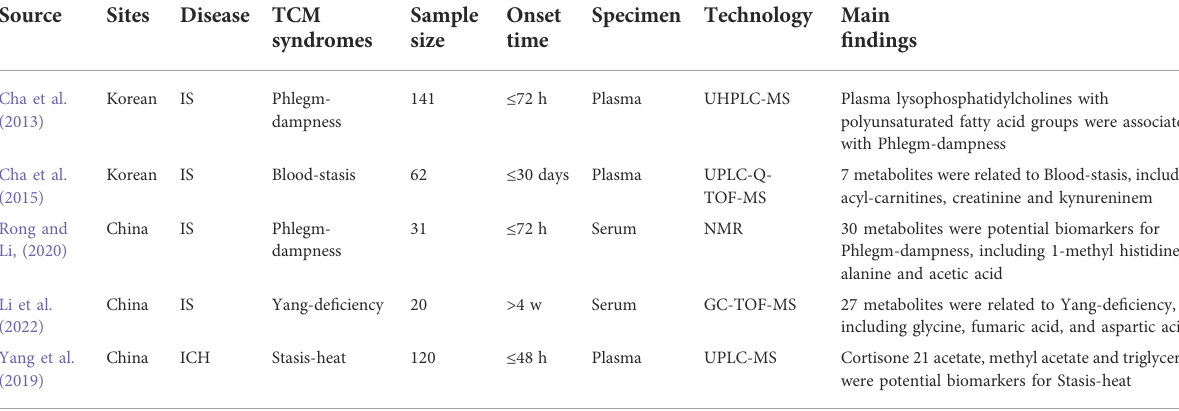
TABLE 4 Summary of the main fi ndings of the included metabolomics